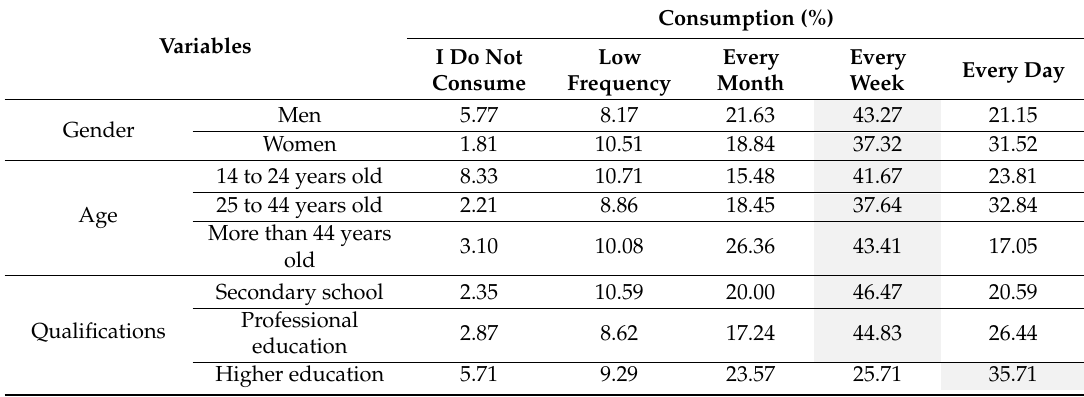
Table 16. Series consumption according to demographic variables.